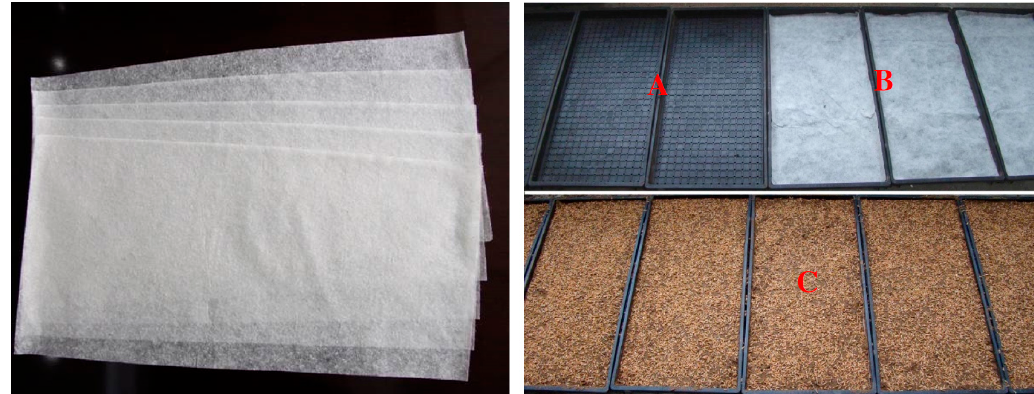
Figure 1. ( left ) The ramie fiber/starch nonwoven film; and ( right ) Its application. A: Empty plate for raising rice seedlings for machine-transplanting, B: The film is padded on the bottom surface of the plate, C: The film is covered with cultivated soil and rice seeds are sown on it.